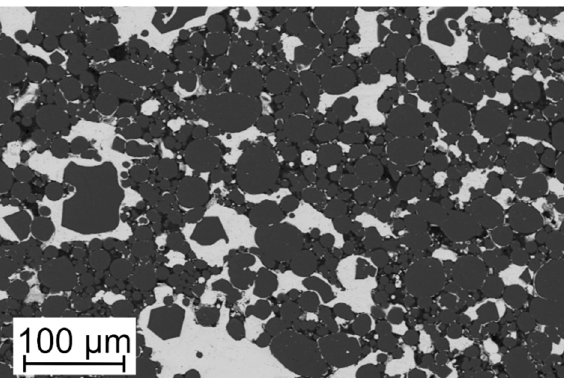
Figure 3. SEM micrograph of Al-10vol%Sn sample, sectioned on a plane parallel to the compres- sion direction. sion direction.